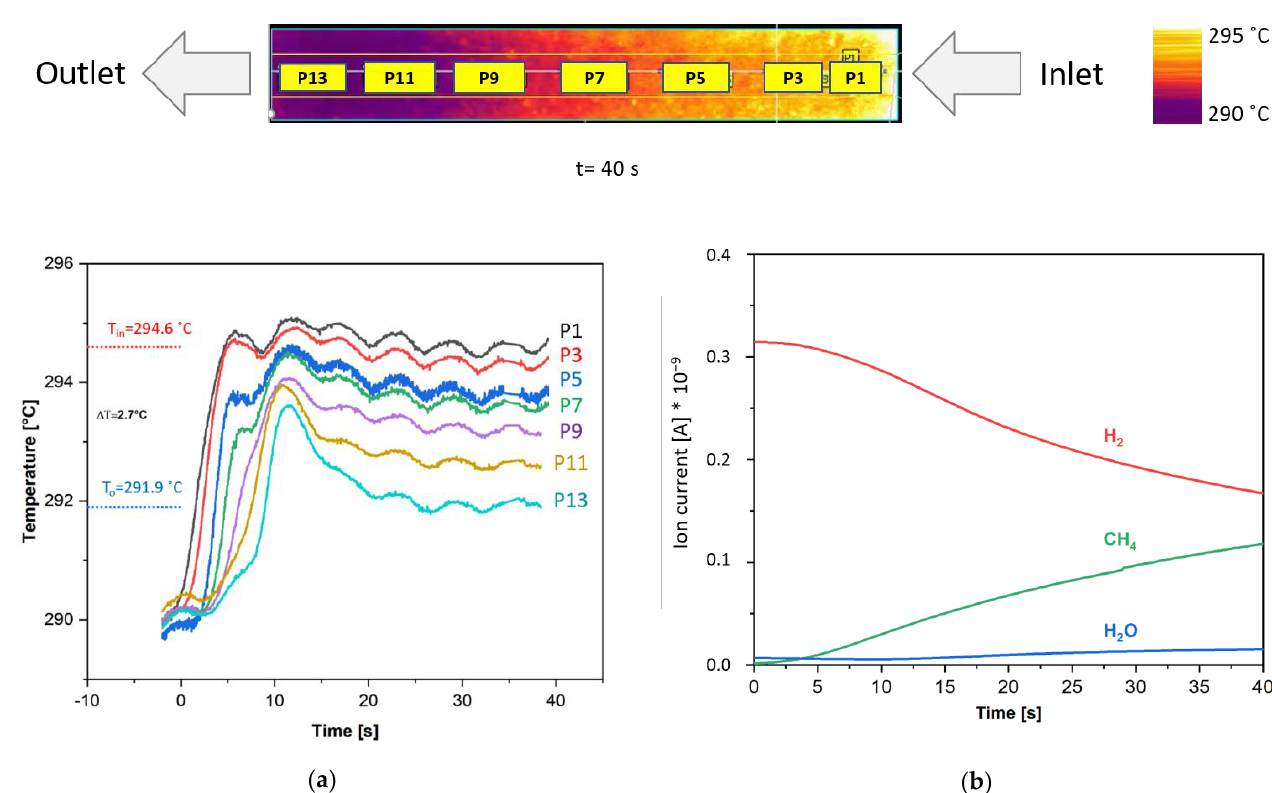
Figure 5. ( a ) Temperature profiles measured with an IR camera during the Sabatier reaction over a 2% Ru/Al 2 O 3 catalyst. P refers to the measurement points, which are highlighted in the thermograph on the top of the figure. ( b ) Measured ion currents of the reactant and products in the same reaction as in panel a.